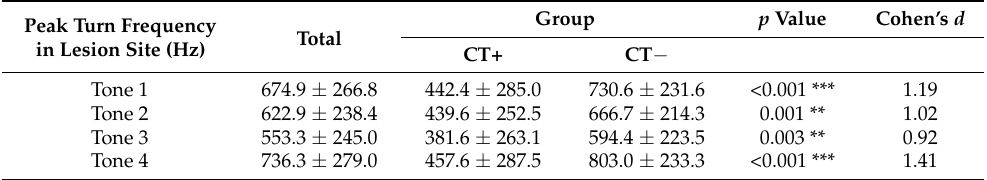
Table 4. Comparison of peak turn frequency between the CT+ and CT − groups when producing the four